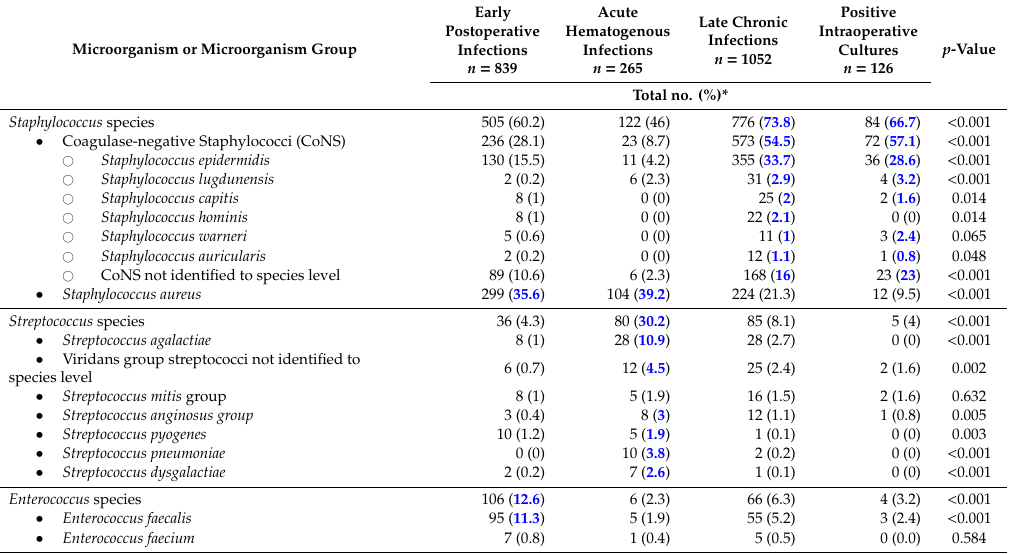
* Percentages marked in bolded blue are statistically significant highest percentages in that row. Two percentages marked in bolded blue in the same row refer to the highest percentages (both are significantly higher than the other two percentages), but with no statistically significant di ff erences between them. Table 3. Microorganisms and group of microorganisms (other than aerobic Gram-positive cocci) involved in prosthetic joint infections according to the four categories of the Tsukayama classification.